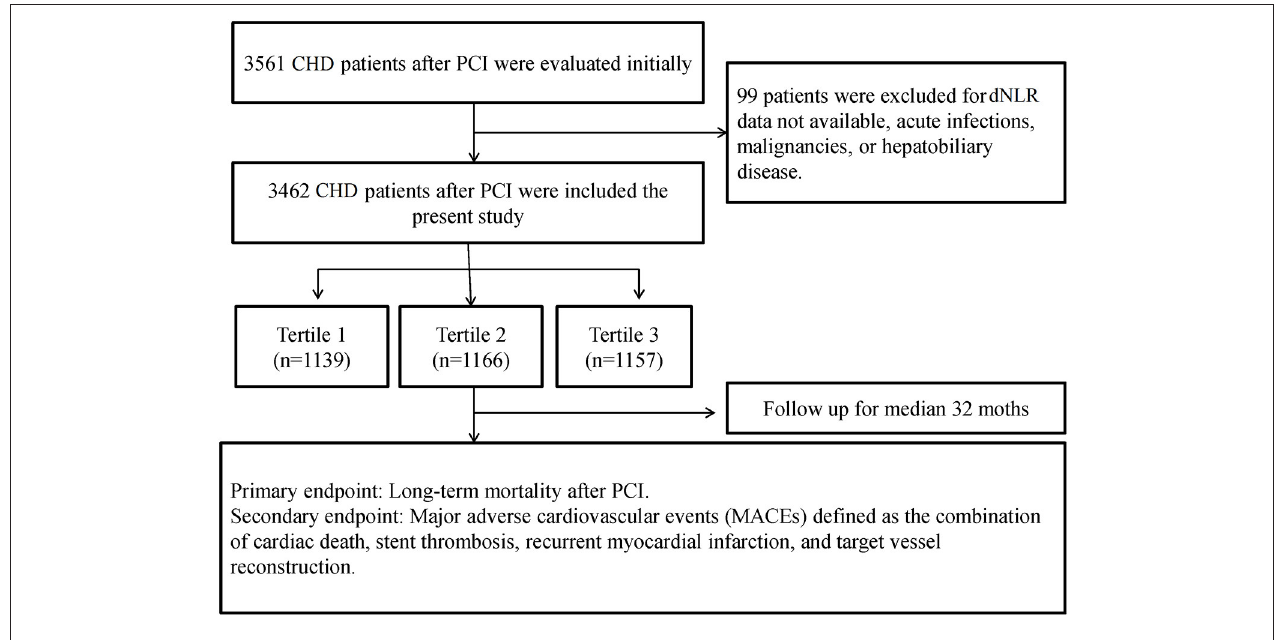
FIGURE 1 | The follow chart of participant